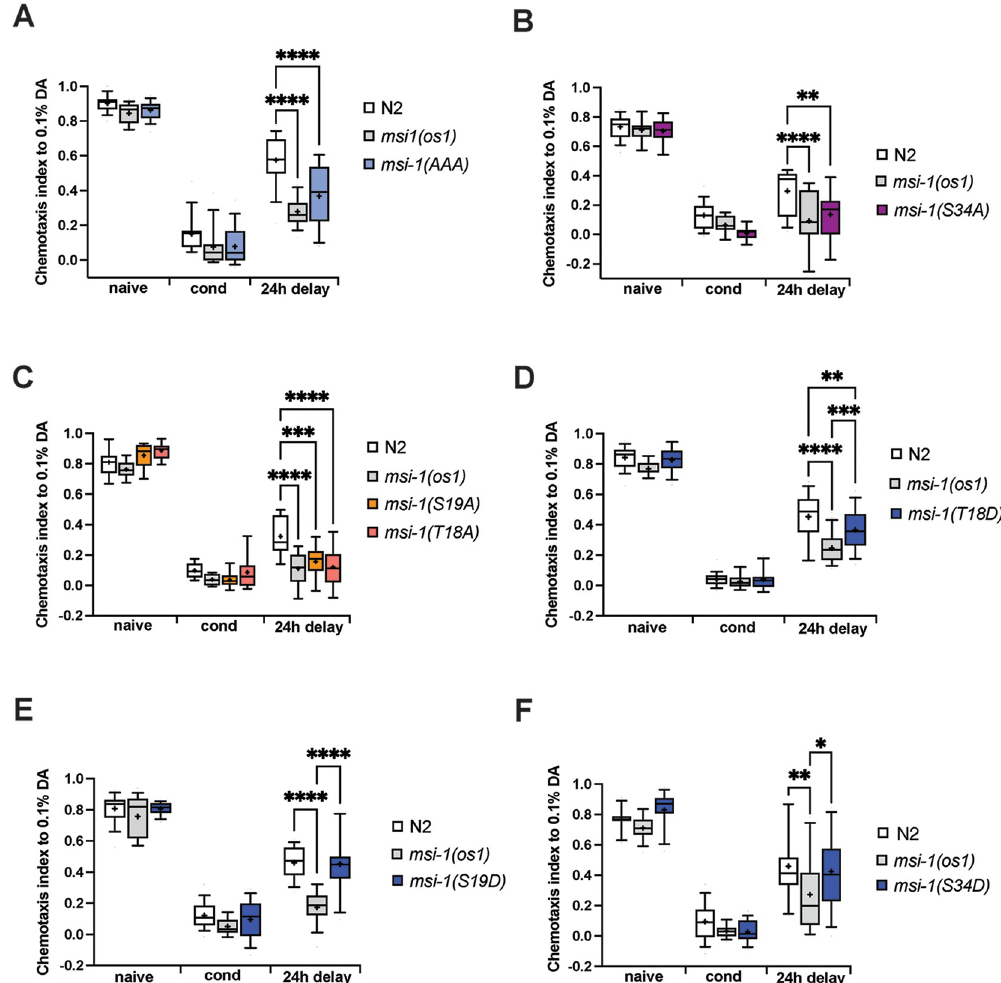
Fig 4. Long-term memory phenotyping of msi-1 phospho-mutants. Negative olfactory LTAM was tested in WT, msi-1 (os1) and animals with phospho-inhibitory (A-C) or phospho-mimetic (D-F) mutations as indicated. Worms were assayed toward 1:1000 diluted DA before (naive), directly after conditioning (cond) or followed by a 24-hour recovery phase (24h delay). All experiments were done in triplicates and repeated at least four times. Data is represented in boxplots with 10 and 90 percentile whiskers. Significance was tested with 2-way ANOVA and post hoc t-tests . ns = not significant, asterisks represent Bonferroni-corrected p-values: � = p < 0.05, �� = p < 0.01 ��� = p < 0.001 and ���� = p < 0.0001. 2,4,5-trimethylthiazole, an odour sensed by the AWA neuron (S1A Fig). Additionally, we used odr-10(ky32) mutants [28] as a negative control to ensure that starvation alone is not responsi- ble for the behavior of worms. As previously shown [28], we observed that odr-10 na ï ve worms do not respond to low concentrations of DA but respond normally to 2,4,5-trimethylthiazole (S1B Fig). After conditioning, odr-10 worms retain an intact response to 2,4,5-trimethylthia- zole, suggesting that starvation alone is not responsible for the conditioned behavior of worms to DA. To investigate the effects of phospho-inhibitory mutations on memory performance, we assayed the various mutant strains and found that in worms carrying either the simulta- neous or individual phospho-inhibitory mutations, short-term memory retention was signifi- cantly greater compared to wild-type worms and similar to msi-1(os1) deletion mutant worms (Fig 3A–3C). Interestingly, we found that phospho-mimetic mutations of T18D/S19D sites